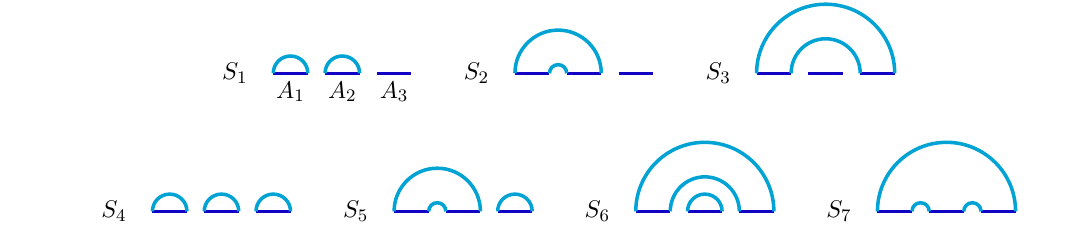
Fig. 3 Leftplot:normalizedtransitioncurve ˜ r crit . = r crit . as a function of α for different values of λ . It is noted that in both of the figures we set (cid:3) = 1